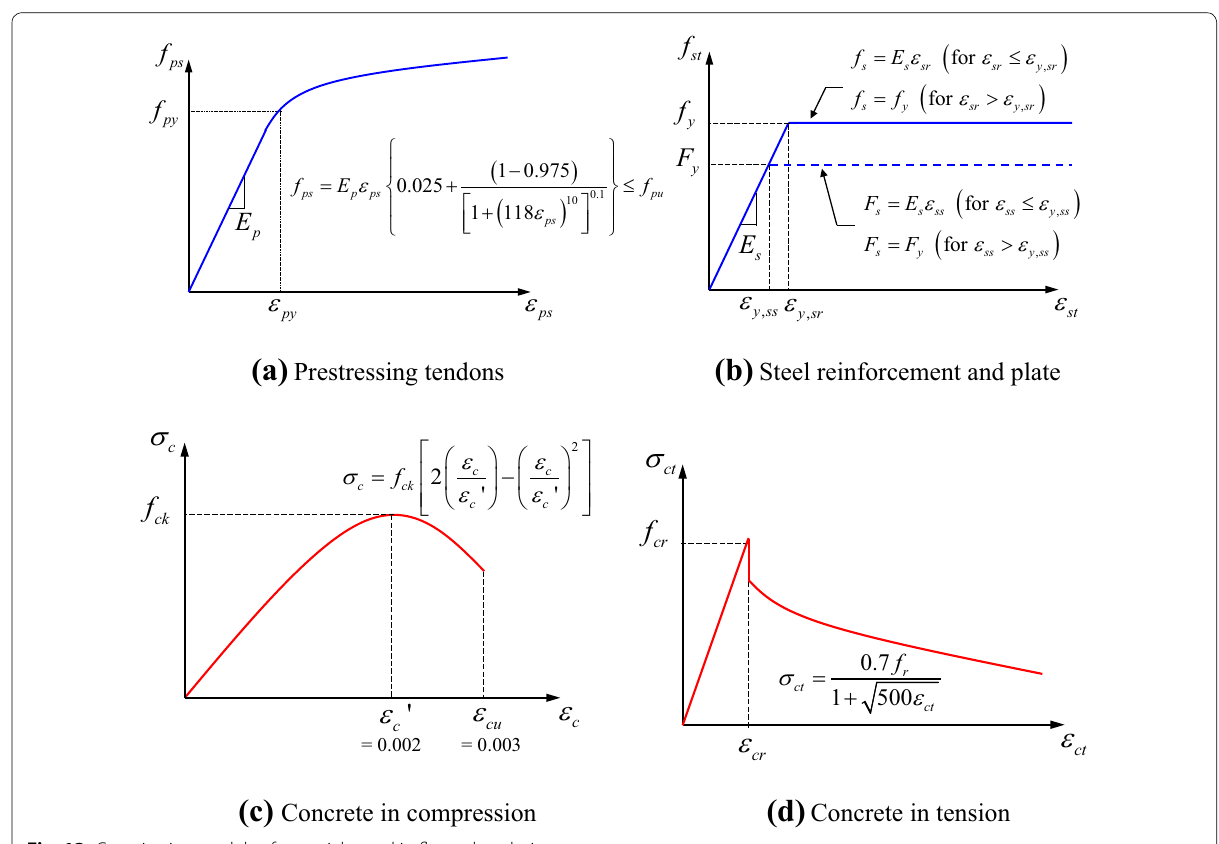
Fig. 13 Constitutive models of materials used in flexural